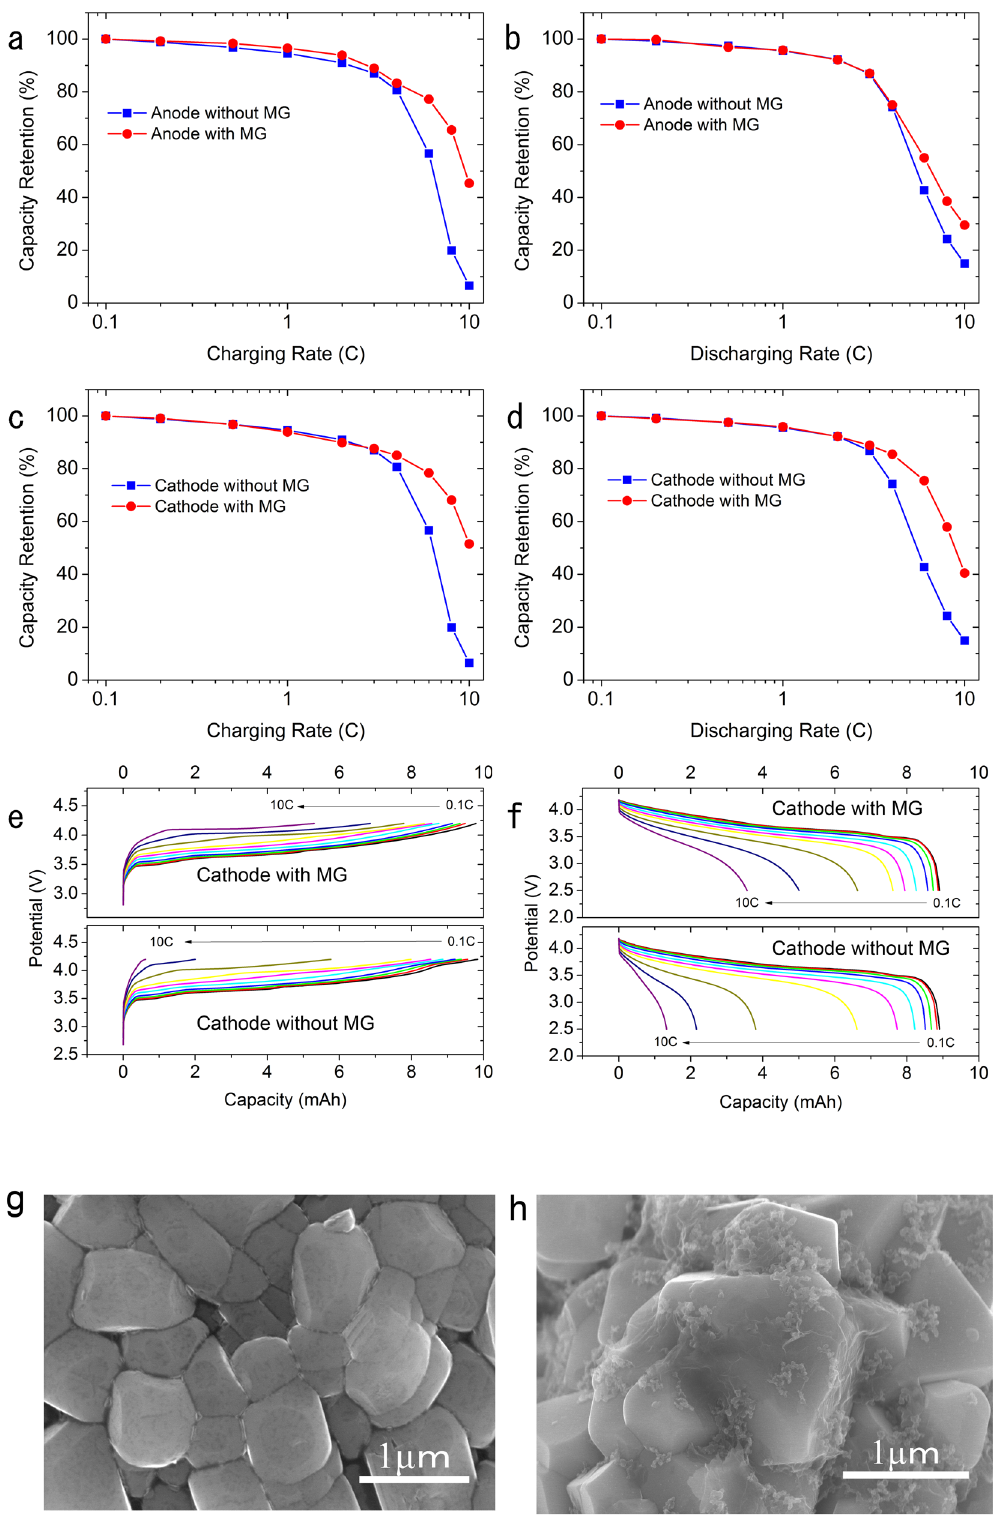
Figure 10. Full-cell charge and discharge rate capability: ( a ) charge rate capability of graphite anode with or without MG ( b ) discharge rate capability of graphite anode with or without MG ( c ) charge rate capability of NCM111 cathode with or without MG ( d ) discharge rate capability of NCM111 cathode with or without MG ( e ) charge curves of 0.1C, 0.2C, 0.5C, 1C, 2C, 3C, 4C, 6C, 8C, 10C with or without MG in cathode, and ( f ) discharge curves of 0.1C, 0.2C, 0.5C, 1C, 2C, 3C, 4C, 6C, 8C, 10C with or without MG in cathode. ( g ) SEM image of cathode electrode surface without MG adding and ( h ) SEM image of cathode electrode surface with MG. Carbon black attached MG were covered on the surface of cathode